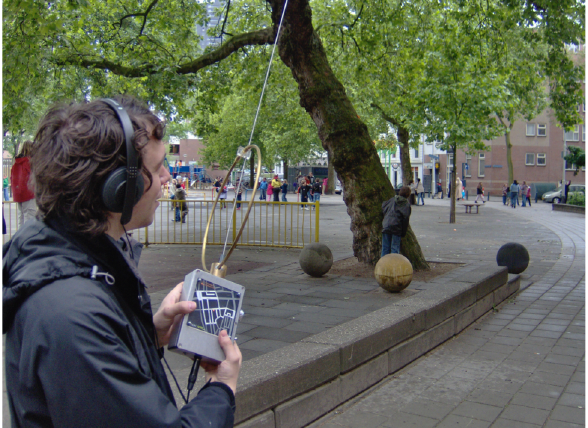
Figure 1 | A participant is experiencing Radioscape as part of the Electromagnetic Bodies exhibition in Rotterdam, 2006. Image courtesy Studio Edwin van der